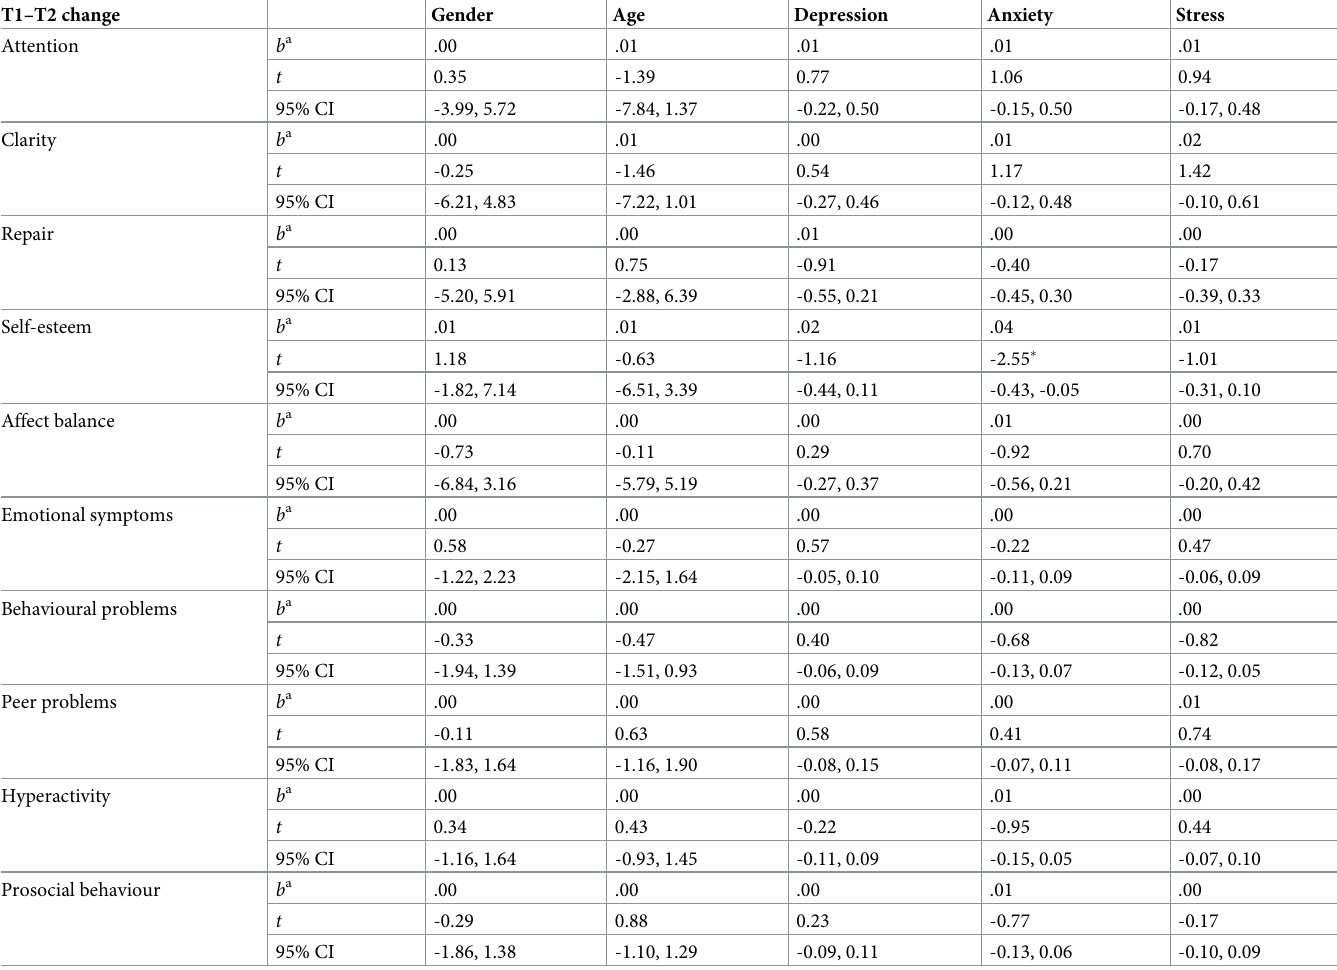
Table 6. Moderating effects on the intervention programme. T1–T2